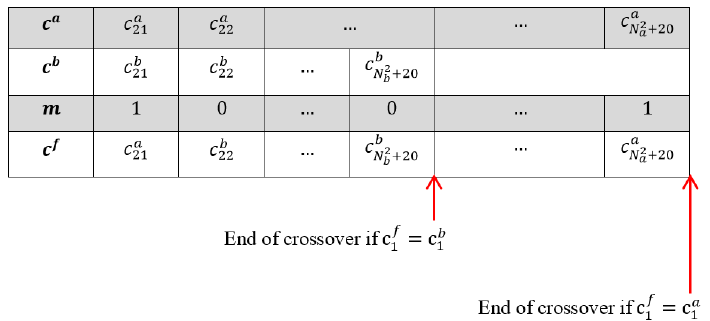
Figure 4. Operator crossing in the second part of the genome. Adapted from Ferreira, Ludermir and Aquino